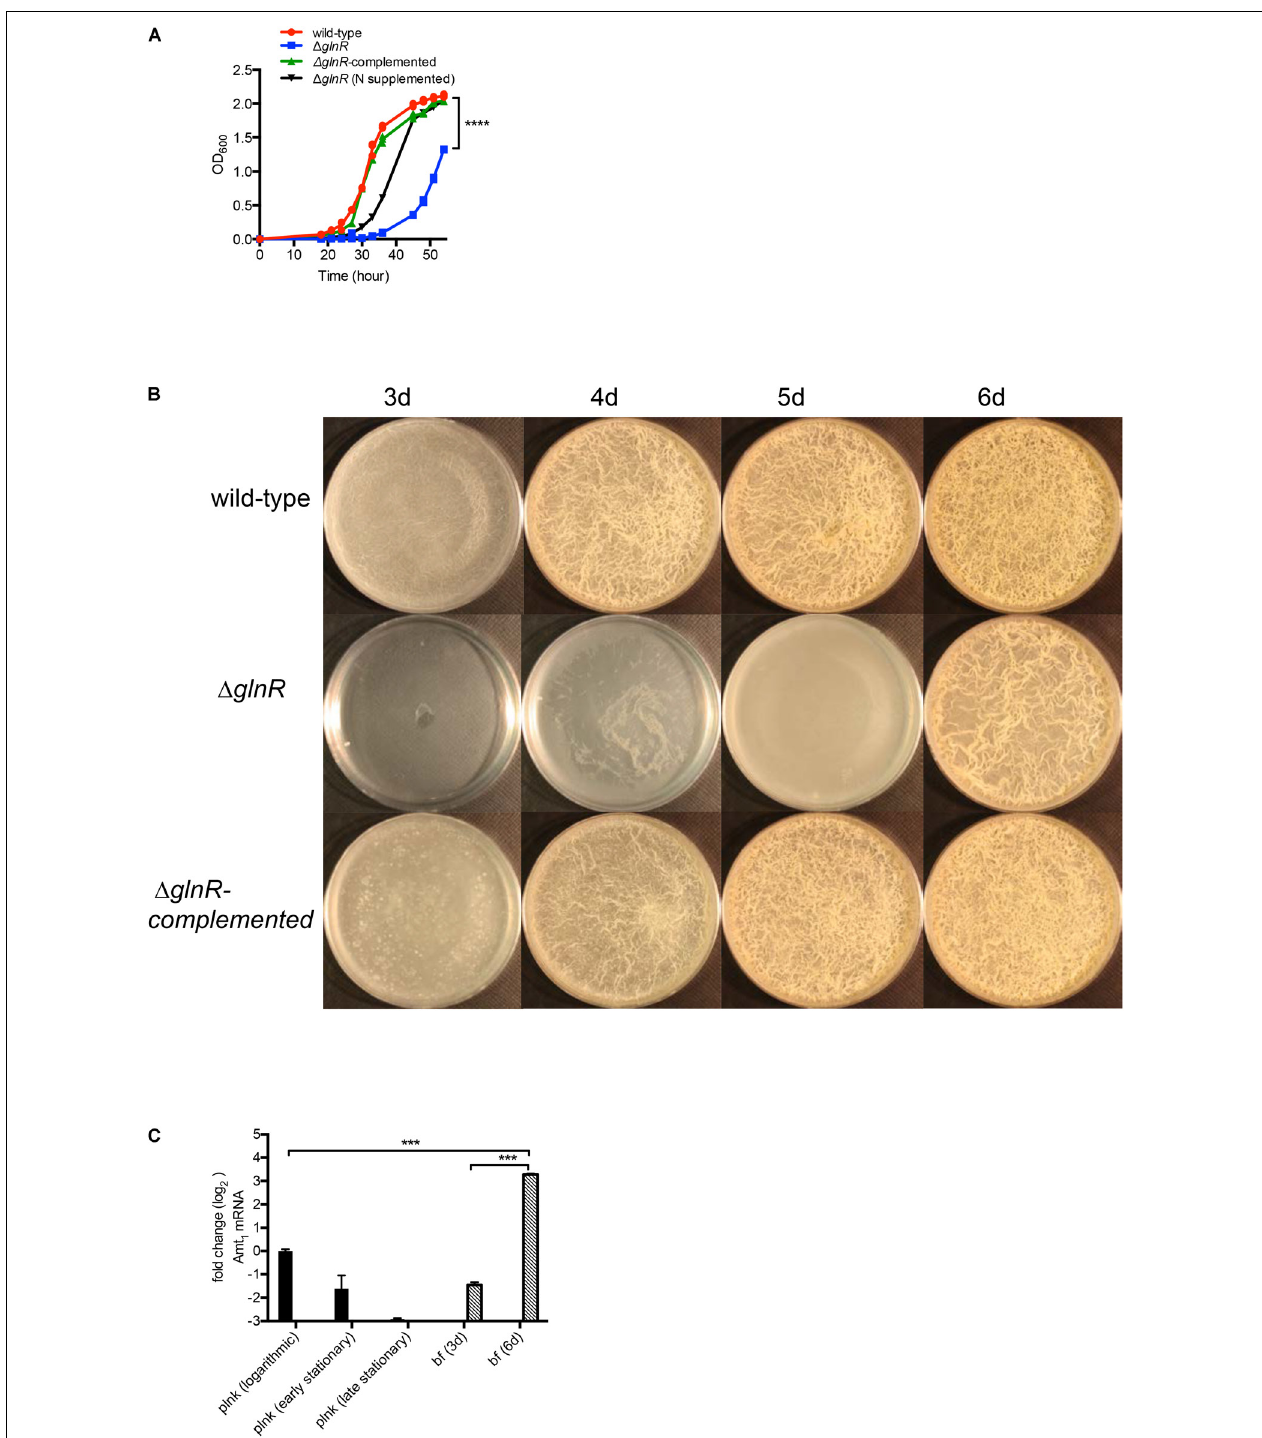
FIGURE 1 | GlnR-dependent growth of M. smegmatis in planktonic and biofilm cultures in Sauton’s medium. (A) Planktonic growth of wild-type, (cid:49) glnR and (cid:49) glnR -complemented strains in Sauton’s medium with 0.05% (v/v) Tween80. Growth of (cid:49) glnR is also rescued by supplementation of Sauton’s medium with 0.5% (w/v) casamino acid and 0.2% (w/v) ammonium sulfate. (B) A top-down view of pellicle biofilms of wild-type, (cid:49) glnR and (cid:49) glnR complemented strains in detergent-free Sauton’s medium at the indicated time point. (C) Expression of a GlnR-dependent ammonium transporter (Amt 1 ) in planktonic (plnk) and biofilm (bf) cultures of wild-type M. smegmatis at indicated stages of growth. Logarithmic, early- and late-stationary phases of planktonic cultures correspond to OD 0.3, 1.5 and 2.5, respectively. Stages of biofilms at which cells were harvested are indicated as days after incubation. Expression was determined by real-time PCR and normalized with the SigA transcripts. Data represent mean of two independent experiments. ∗∗∗ and ∗∗∗∗ denote p < 0.001 and 0.0001, respectively ( t -test).